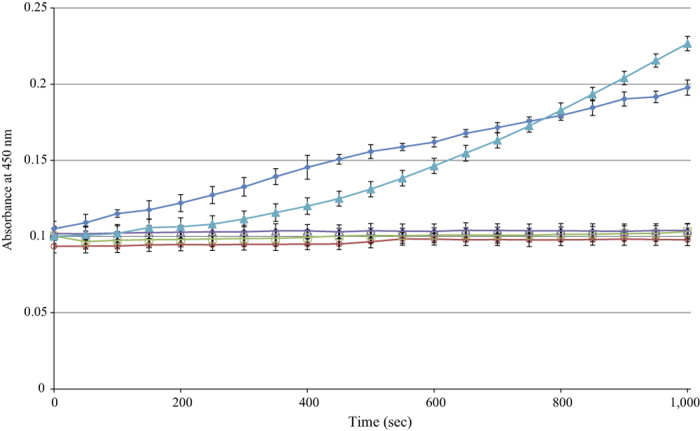
PNP release (absorbance at 405 nm) from the blocked PNPG7 substrate upon incubation with 6 U MaAmyB enzyme preparations and various control samples, (done in triplicate ± SD).Results obtained for MaAmyB and the positive control (EV + MaAmyA2 α-amylase + α-glucosidase) are significantly different (T-test for 0–500 sec, p-value: 0.028).  = MaAmyB;  = empty vector (EV) control;  = Empty vector (EV) + MaAmyA2 α-amylase;  = EV + α-glucosidase;  = EV + MaAmyA2 α-amylase + α-glucosidase.